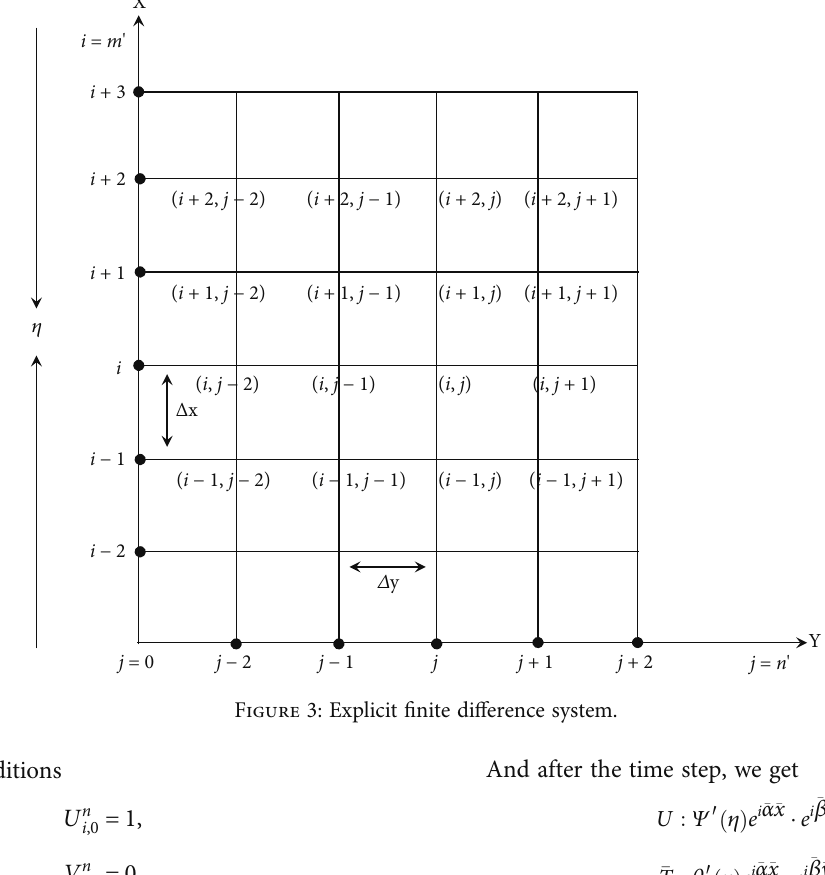
Figure 3: Explicit fi nite di ff erence